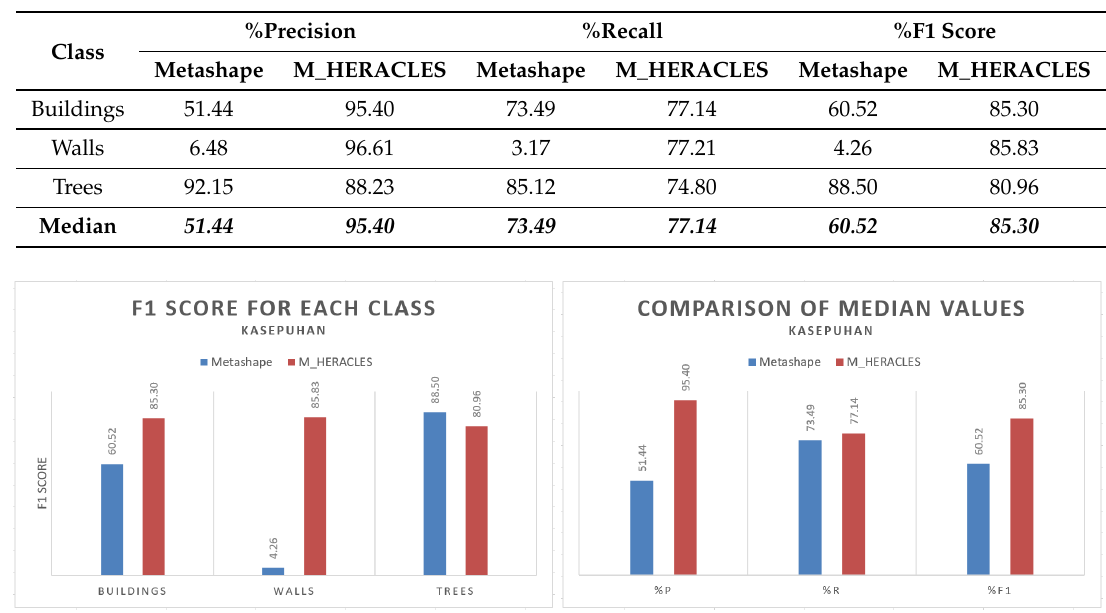
Metashape and M_HERACLES.